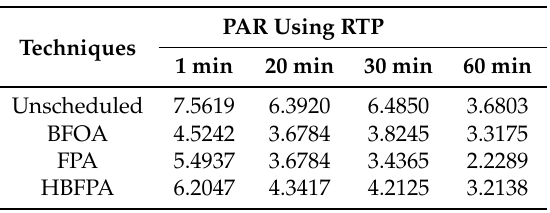
Table 8. Peak to average ratio for 24 h (for single homes).